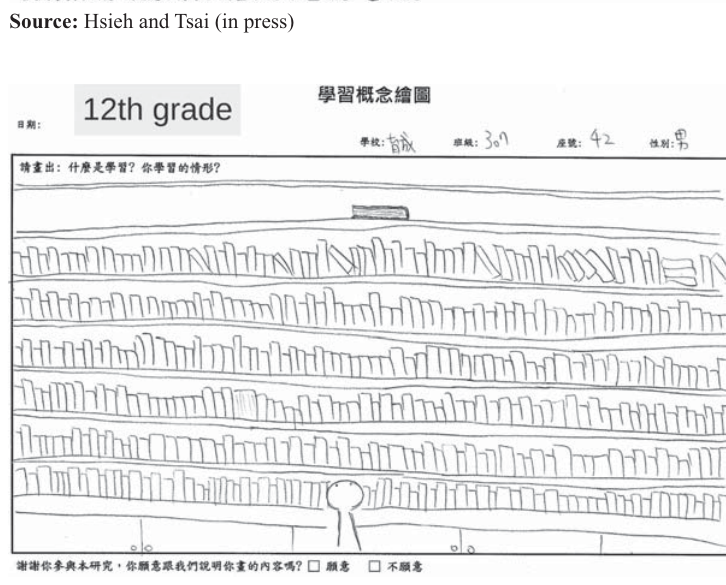
Source: Hsieh and Tsai (in press)